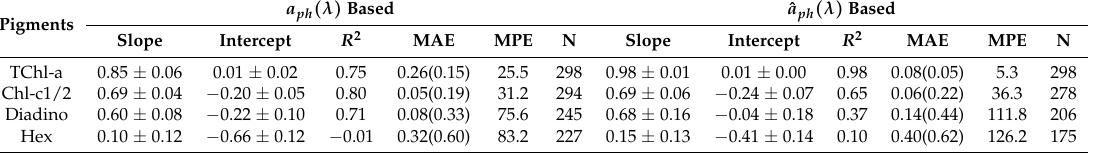
Table 5. Statistics of phytoplankton pigment retrieval using SVD-NNLS based on leave-one-out cross-validation. MAE is in mg m − 3 (values outside the parentheses were calculated with linear-scale values, while inside the parentheses with log10-scale values) and MPE in %. “Perturb 1, 2 and 3” represent the input data with perturbations of pigment concentrations solely, a ph ( λ ) solely and both,